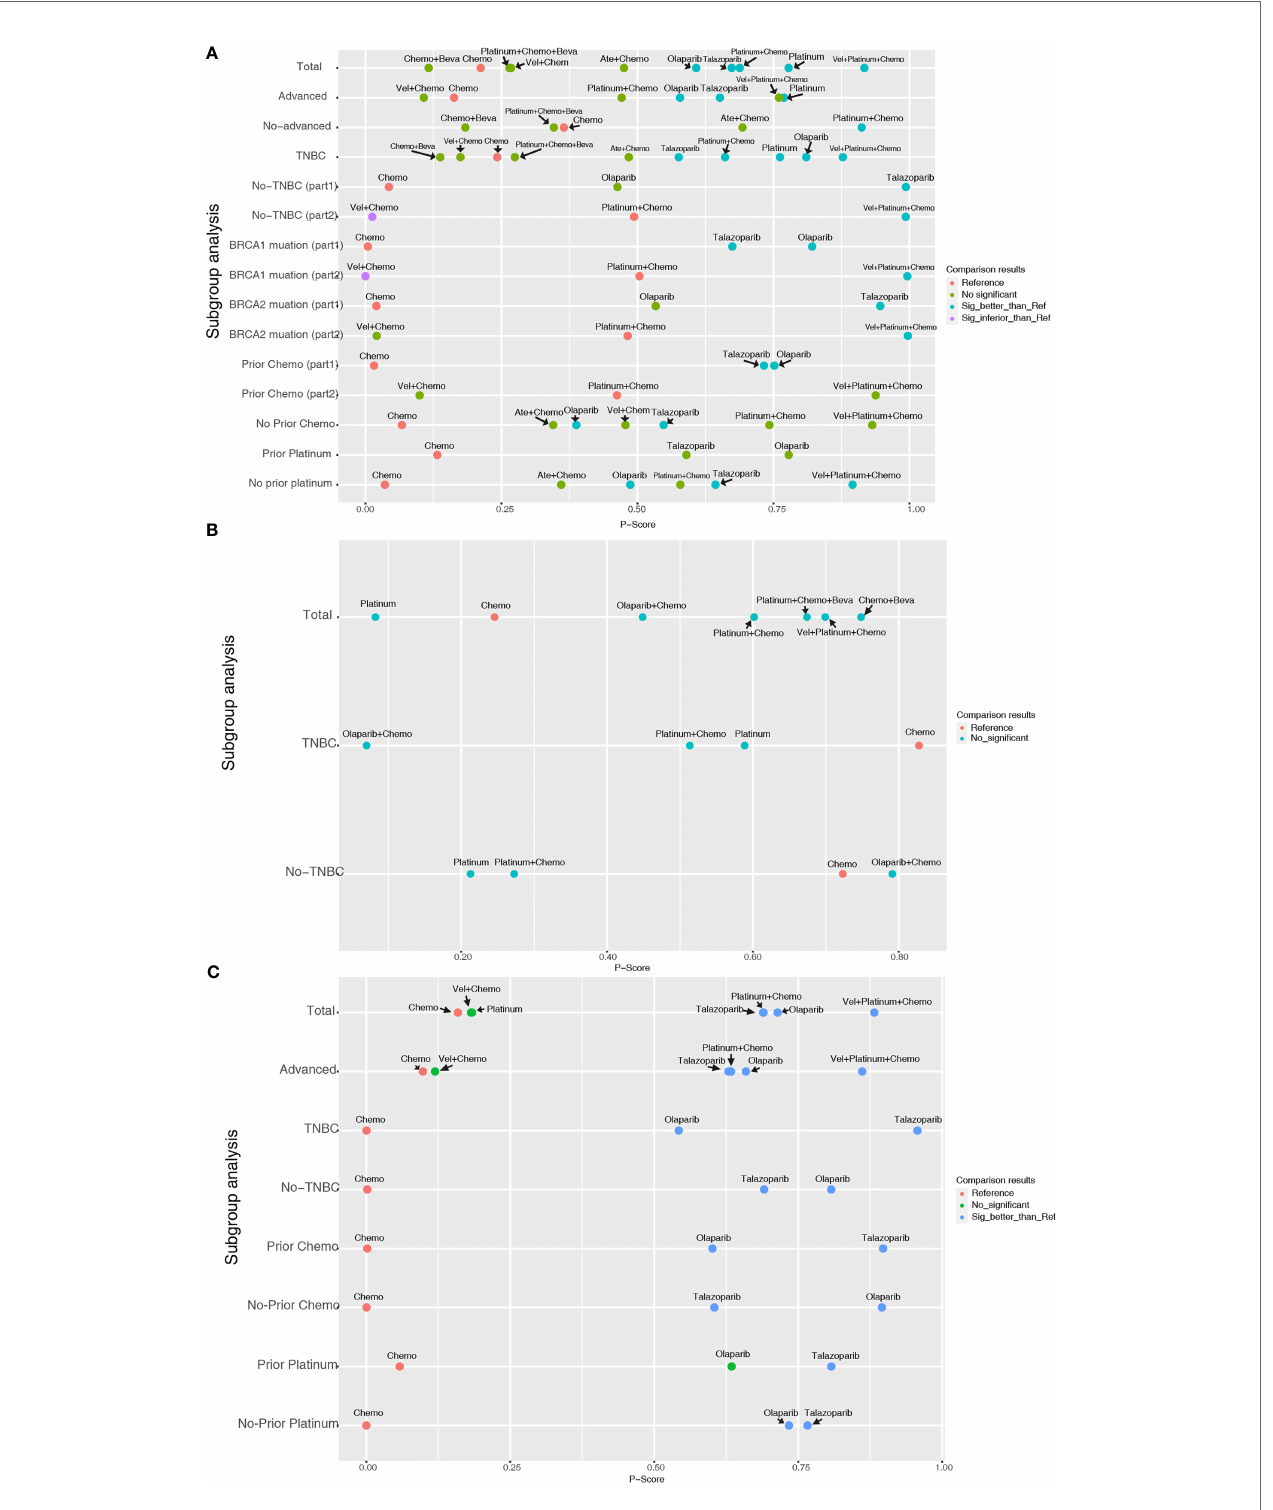
FIGURE 4 | Entire and subgroup analyses of PFS (A) , pCR (B) , and ORR (C) results by network meta-analysis according to the P-score. Each dot represents an intervention, its ordinate represents the subgroup to which it belonged, and its abscissa represents the p-score results from the network meta-analysis. The various colors of the dots indicate whether there is a statistical difference compared with the reference (commonly